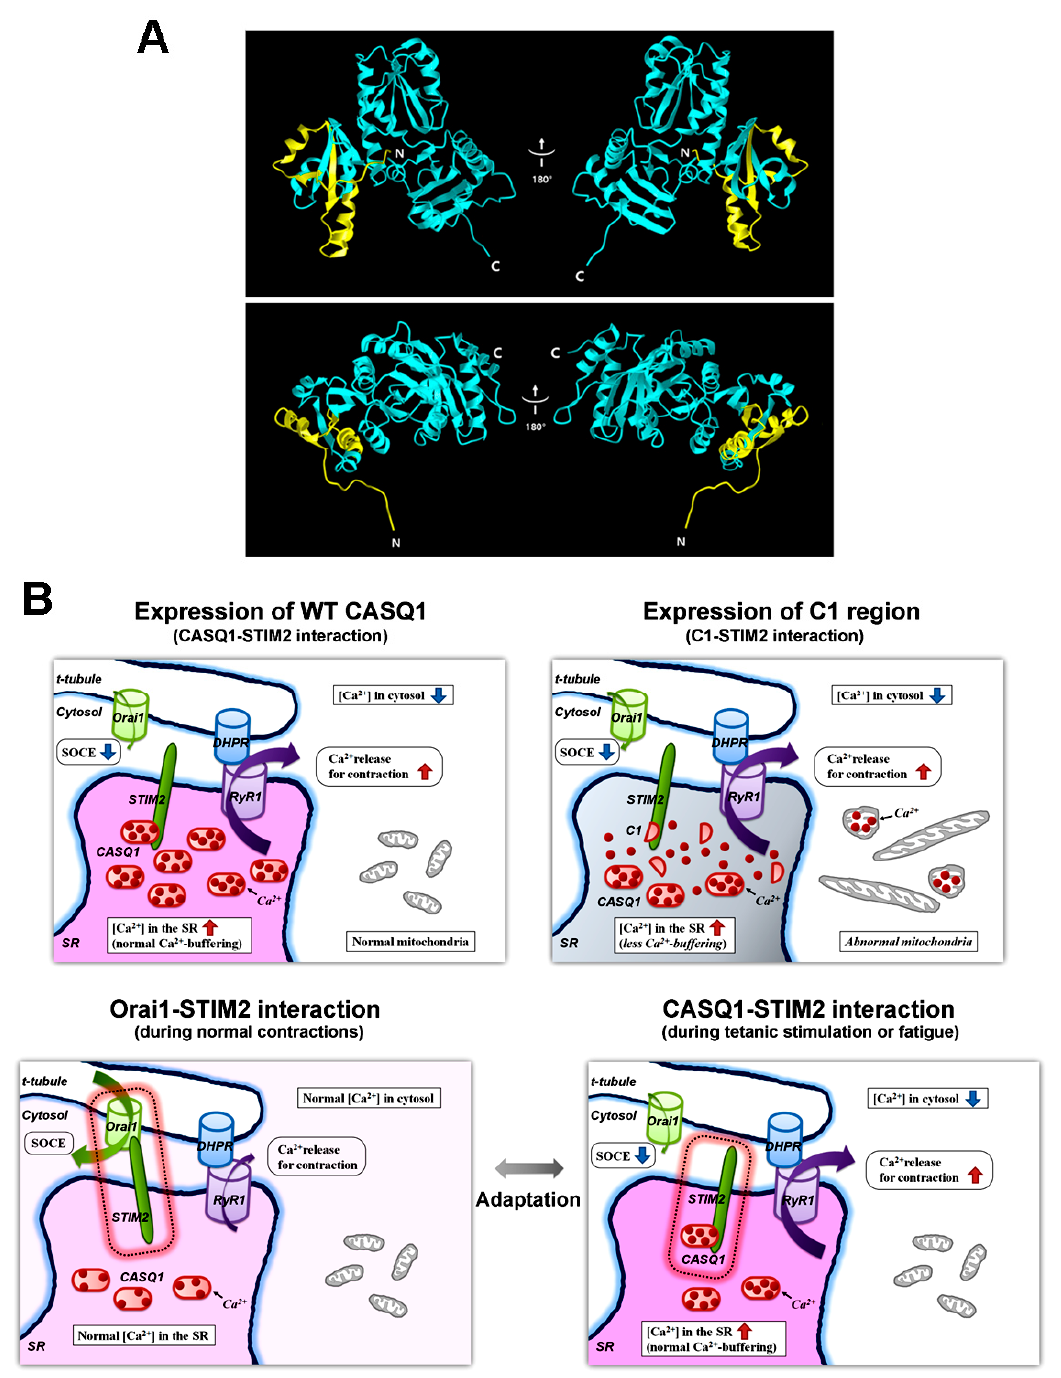
Figure 5. 3D structure of human CASQ1 and an adaptation model to situations with repetitive and/or long-term contractions of skeletal muscle: ( A ) 3D structure of human CASQ1 (PDB ID: 3UOM, starting from 3 to 387 amino acids) is presented as a ribbon diagram. The C1 region of CASQ1, which is involved in binding to STIM2, is colored yellow. N or C indicates the N- or C-terminus, respectively. The right images are the 180 ◦ rotated images of the left images along the vertical axis. Images in the lower panel are the top view of the images in the upper panel. ( B ) The overall results of this study are summarized as schematic diagrams in the upper panel. In the lower panel, ‘an adaptation model to situations with repetitive and/or long-term contractions of skeletal muscle’, such as tetanic stimulation or fatigue, is